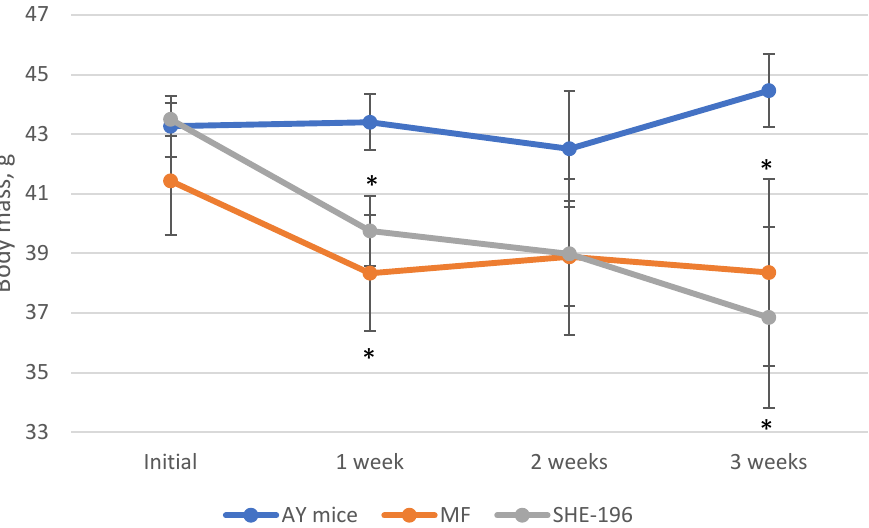
Figure 3. OGTT in C57BL/6 mice prior to the experiment with AY mice. * p < 0.05 compared to Glucose group.